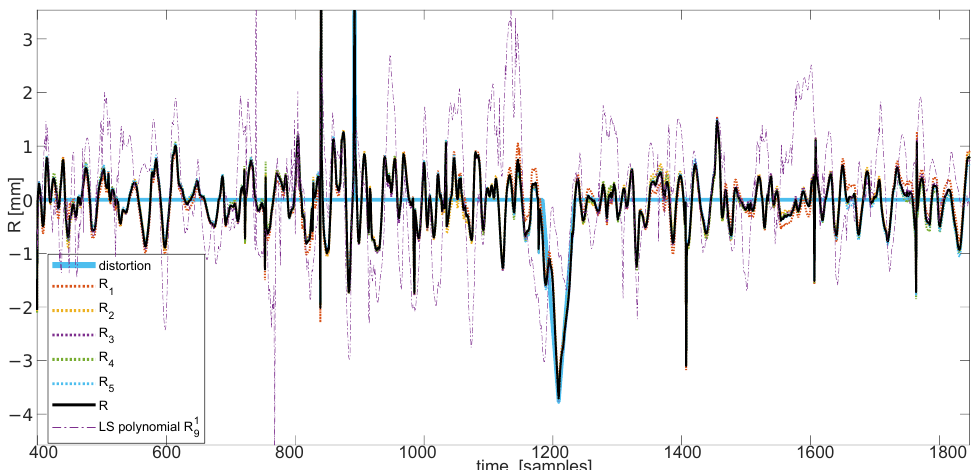
Figure 9. Actual distortion prediction and residuals—component ( R m ) and final ( R ), compared with the polynomial residual R 1 9